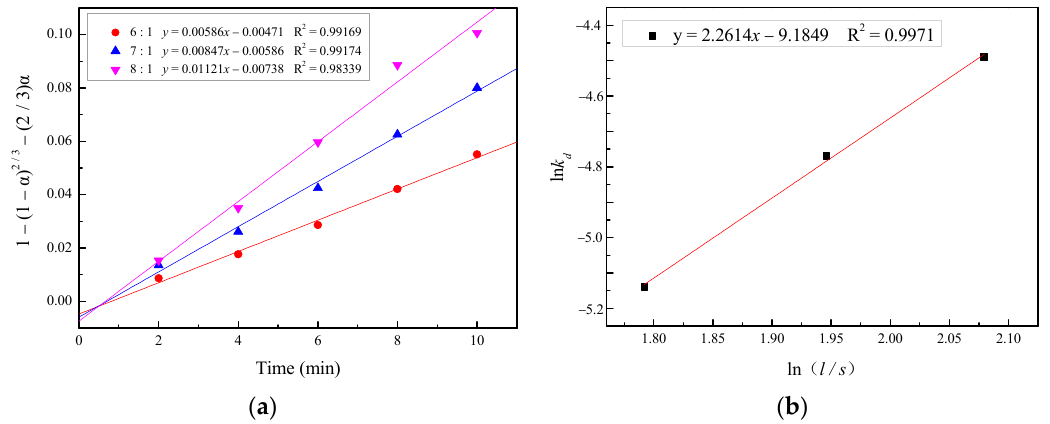
Figure 14. ( a ) Plot of 1 − (1 − α ) 2/3 − (2/3) α versus time for various liquid/solid ratios; ( b ) plot of ln k d versus ln( l/s ).